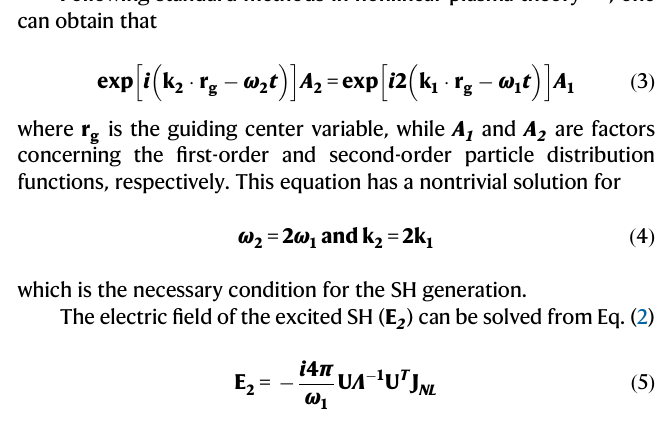
Fig. 5 | Schematic diagram of electron precipitation driven by LBC and SH. After injected from magnetotail (step 1), fresh electrons become anisotropic to excite lower-band chorus (LBC, step 2). Lower-band chorus can self-consistently generate theirsecond harmonic (SH)emissions (step3, observed by theVan Allen Probe mission, VAP), and then they work together (step 4) to cause electron